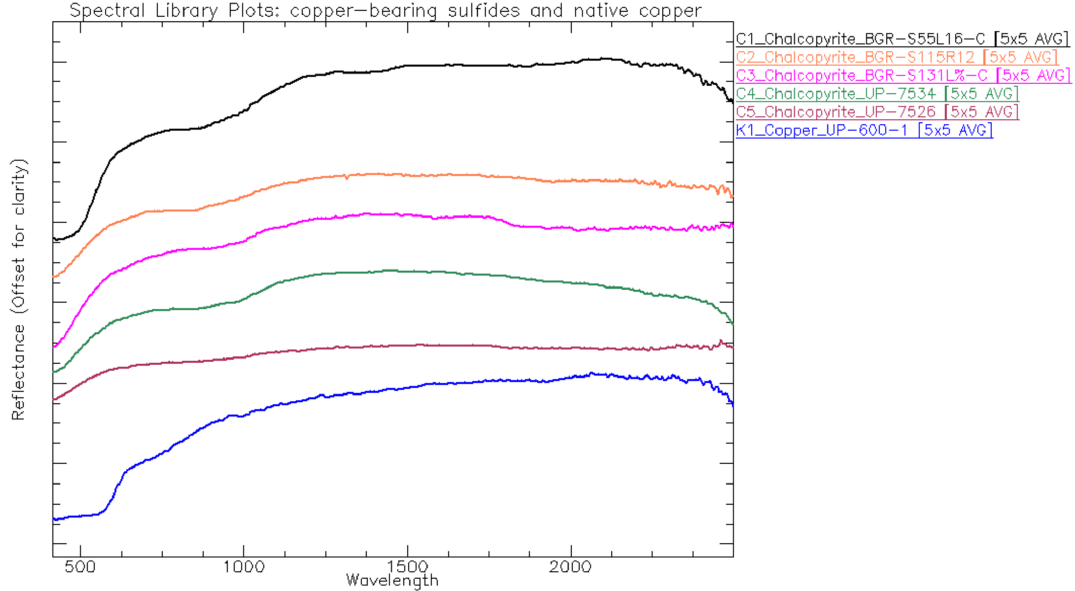
Figure 10. Spectral library plot of the copper-bearing sulfides and native copper.